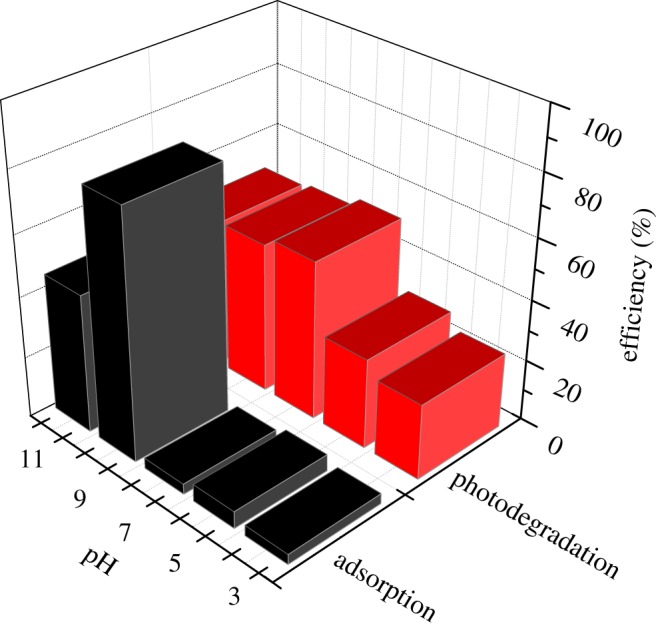
Effect of initial pH value on photocatalytic activity (10 mg l−1 MB, 1.0 g l−1 Tb–TiO2 dose, T = 298 K).